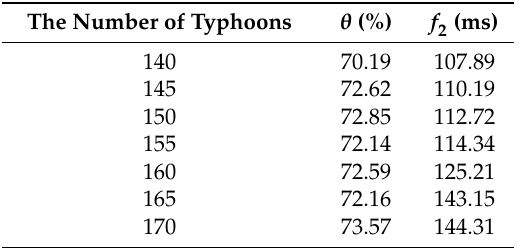
Table 6. Performance of proposed method in different data size.